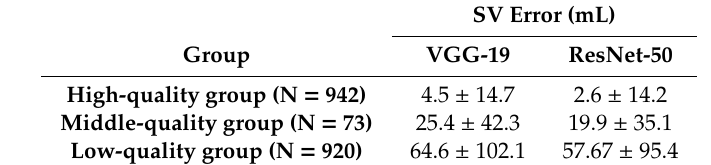
Table 5. The statistic errors of SV in the three groups as classified by the VGG-19 and ResNet-50 models.